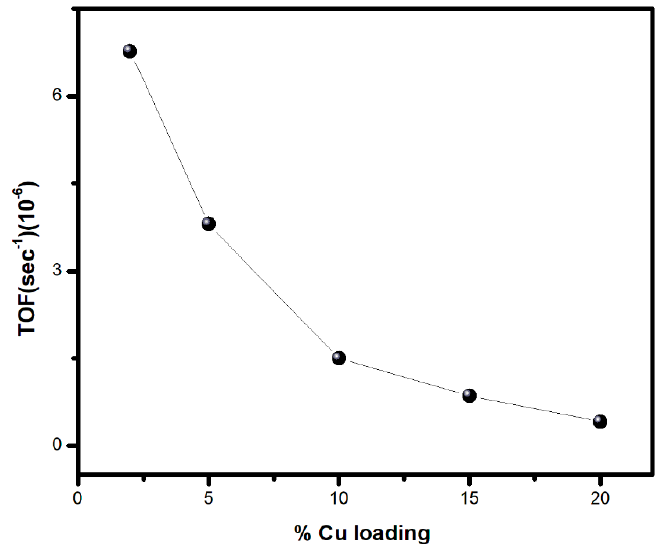
Figure 9. TOF vs. Cu% loading in different Cu/SiO 2 catalysts.